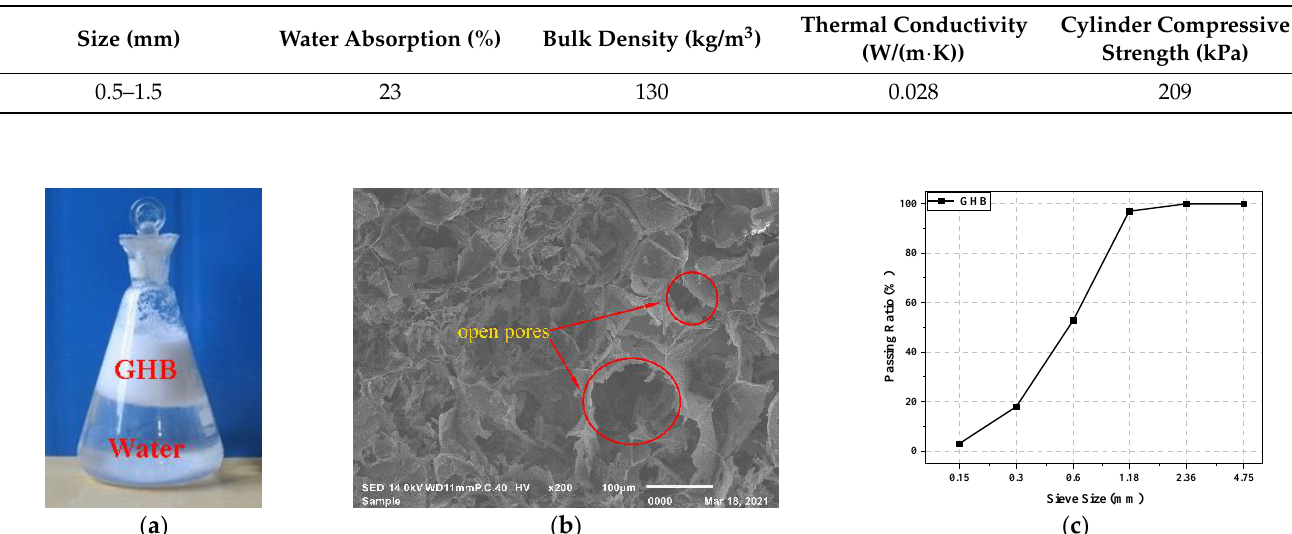
Table 2. Physical properties of GHB.